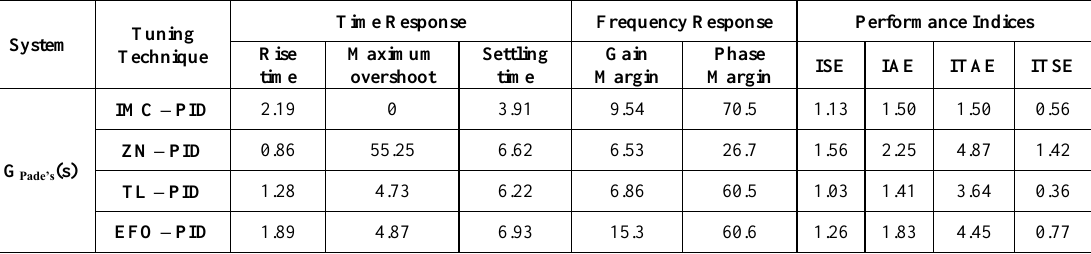
Table 9. Closed loop PID - controlled responses of G Pade’s